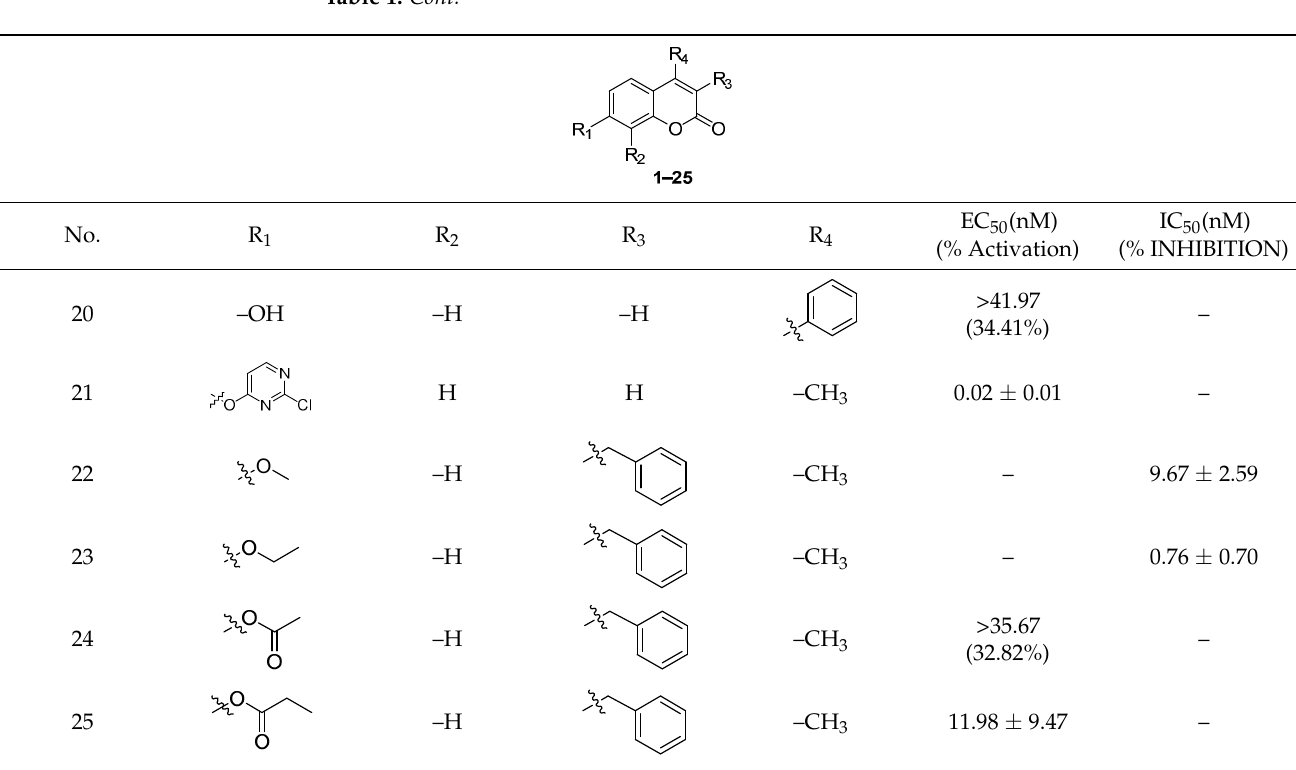
Table 1. In vitro GPCR inhibition IC 50 or activation EC 50 (nM) activities of daphnetin and